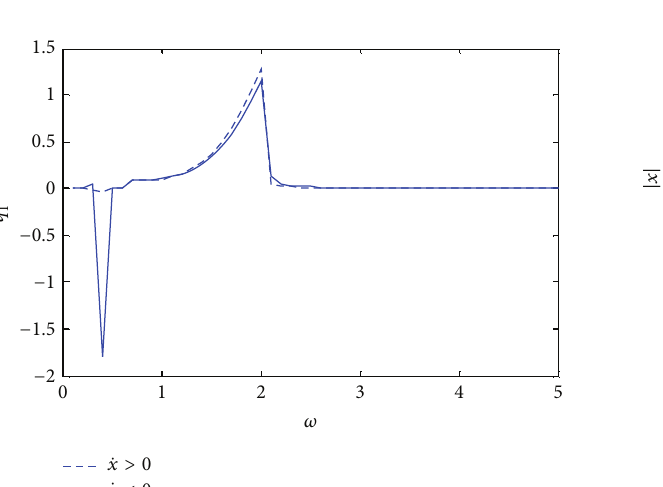
Figure 10: Bistable region of